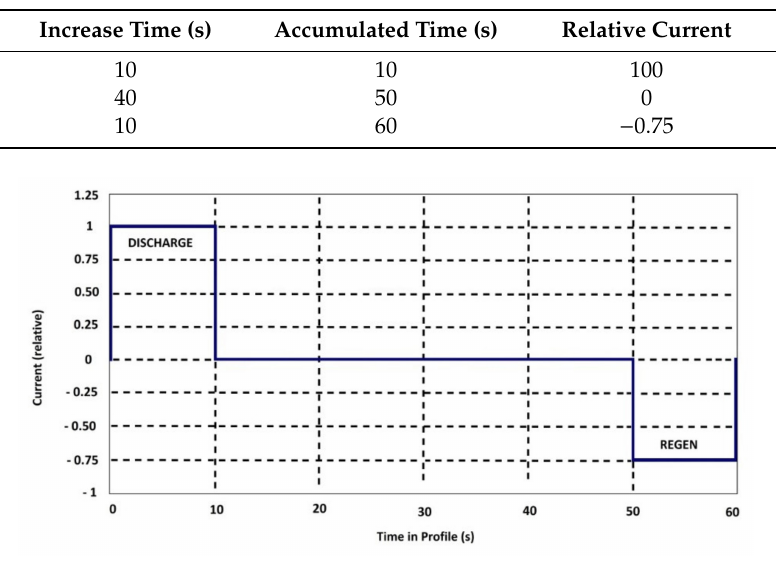
Table 3. The hybrid pulse power characterization (HPPC) test profile [23].